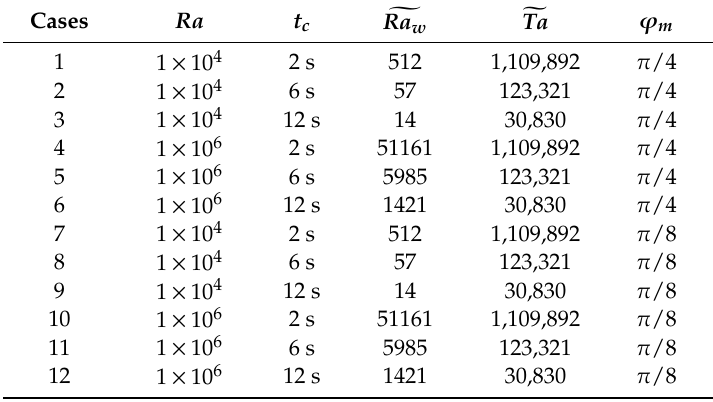
Table 2. Parameters in